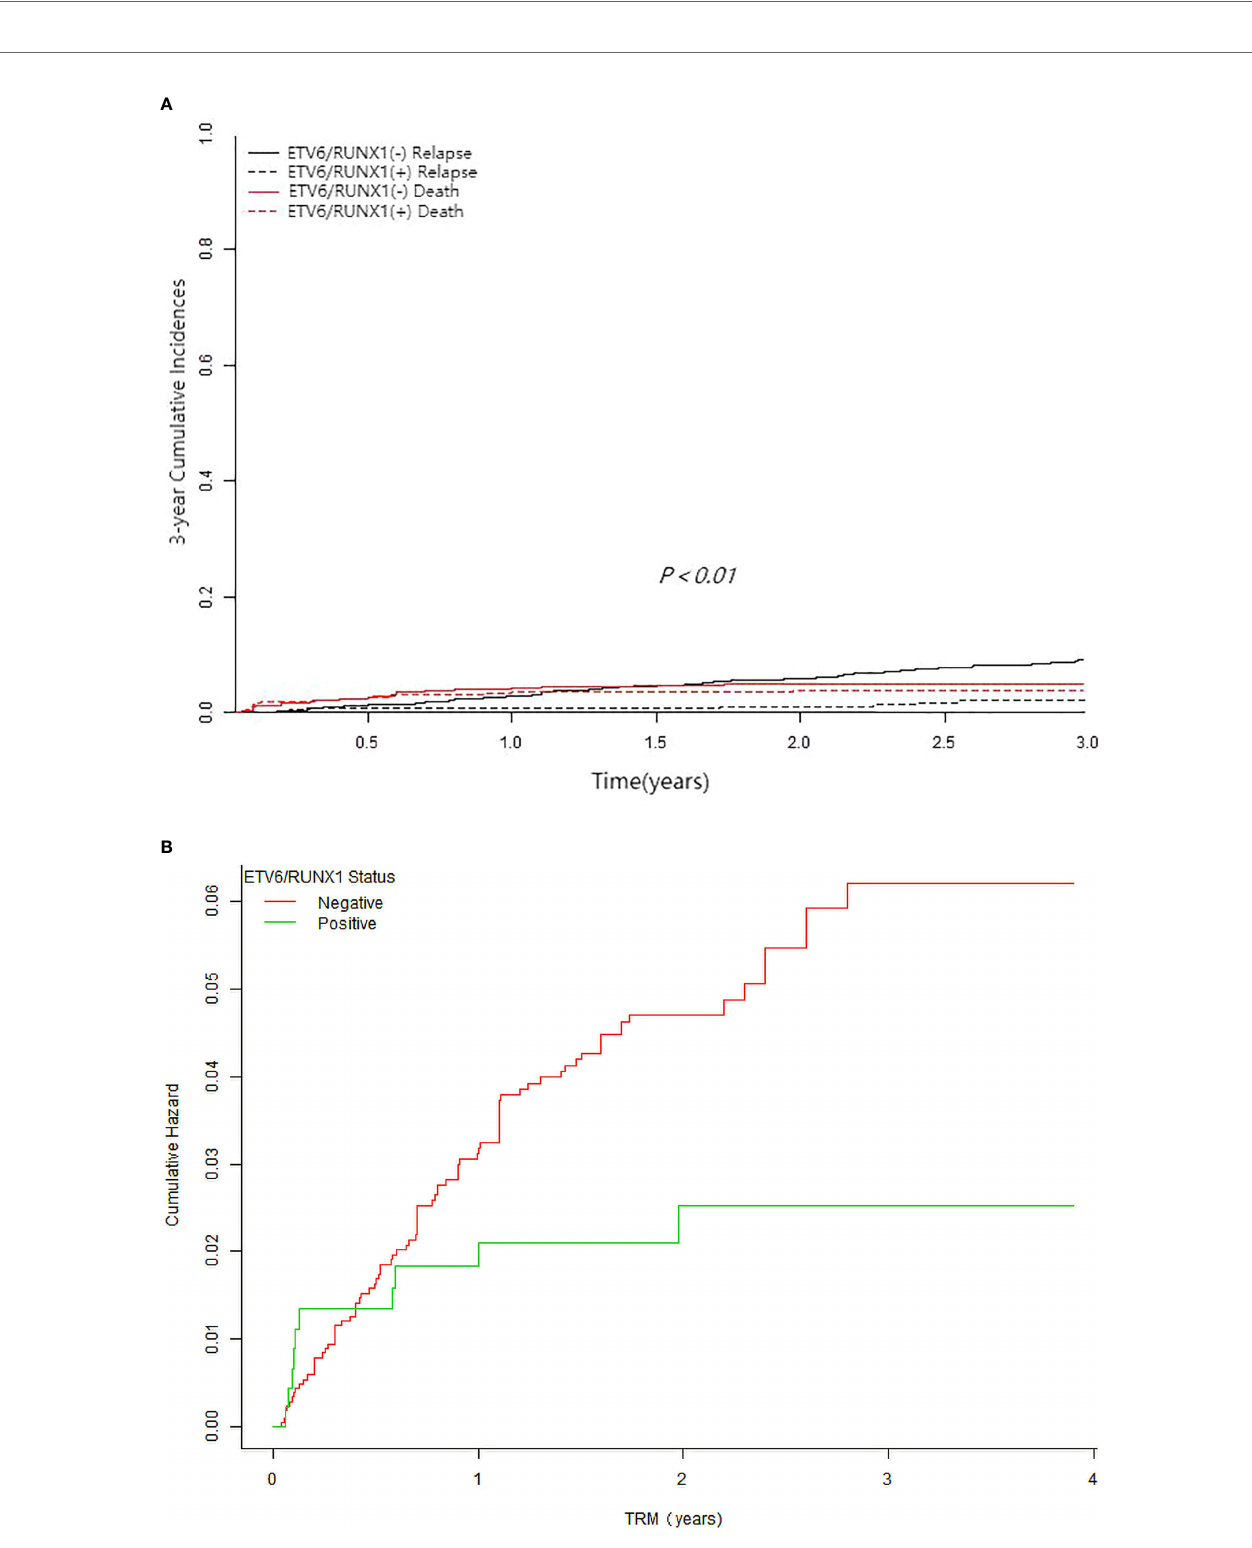
FIGURE 3 | Survival cures of pediatric B-ALL with different ETV6/RUNX1 status. (A) The 3-year cumulative incidence of relapse and deaths of ETV6/RUNX1-positive and ETV6/RUNX1-negative for competing risks. (B) The cumulative incidence of treatment-related mortality of ETV6/RUNX1-positive and